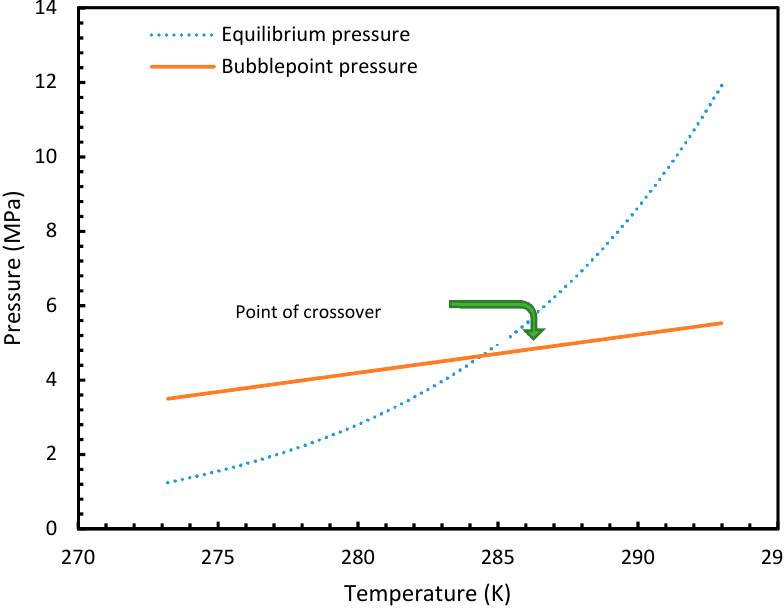
Figure 14. Comparison of Peng-Robinson (PR) and Duan fugacity in the case of CO 2 and CH 4.